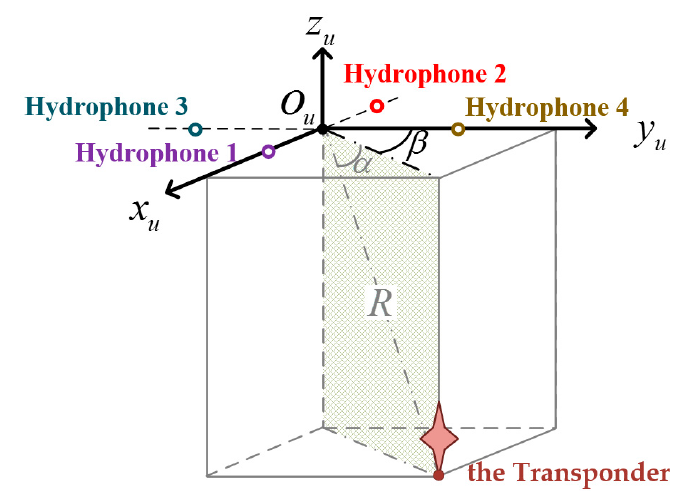
Figure 2. Description of the ultra-short baseline (USBL) array frame and relative position.